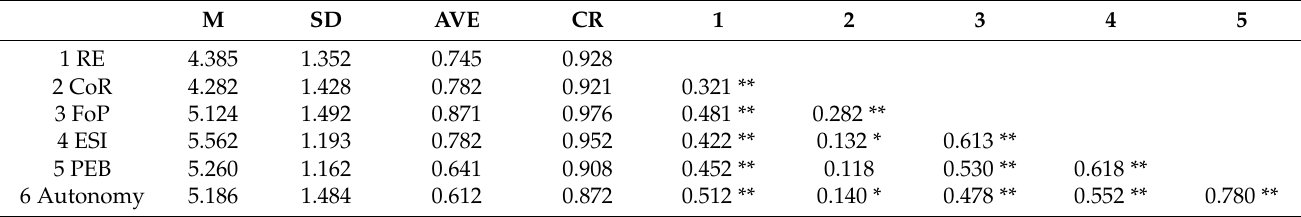
Table 2. Descriptive statistics and reliability of